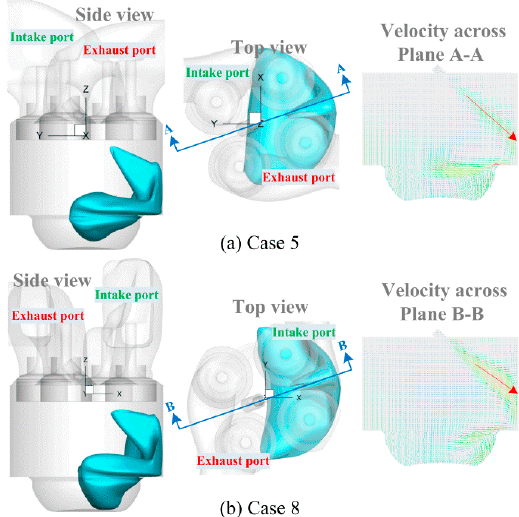
Figure 8. The in-cylinder TKE iso-surfaces (140 (m 2 /s 2 )/kg) and velocity at CA640.